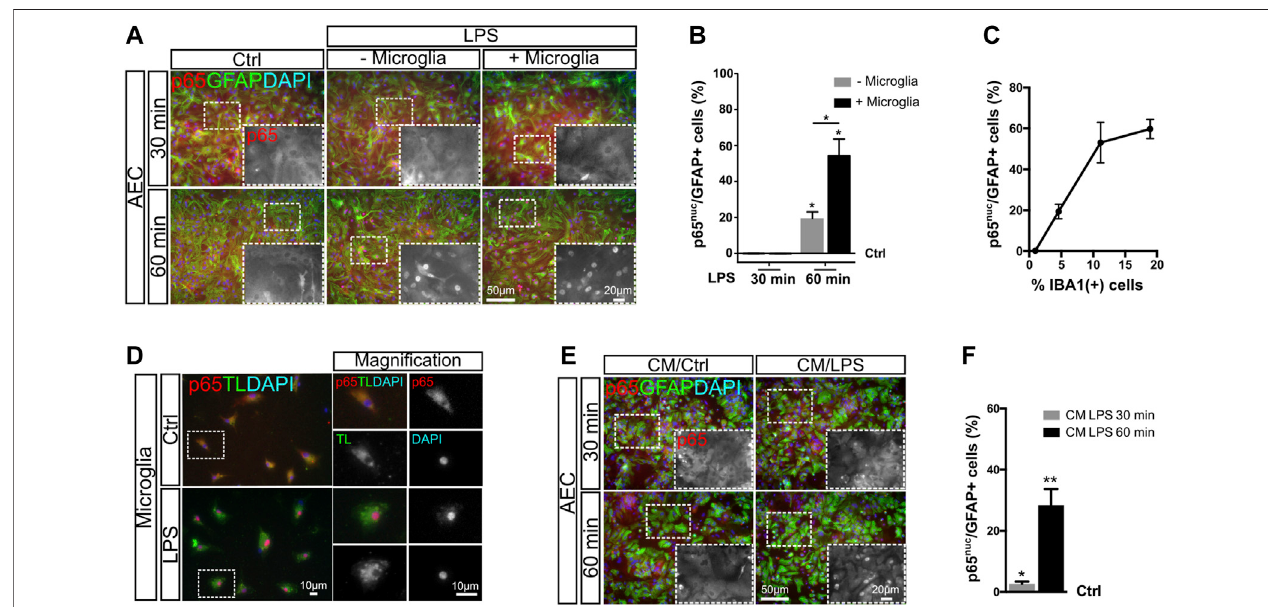
FIGURE 3 | NF- κ B initial activation in astrocytes depends on microglial soluble factors. (A) Astrocyte-enriched cultures (AECs) or microglia-reconstituted AEC (+microglia) were incubated with LPS during the indicated time points in reduced-serum medium. To analyze NF- κ B activation in astrocytes in response to LPS, we performed double immuno fl uorescence staining for GFAP and p65, determining the nuclear p65 localization (p65 nuc ). (B) Graph showing the percentage of GFAP + / p65 nuc -positivecellsfromthetotalGFAP-positivecellsaftersubtractingthepercentage ofGFAP + /p65 nuc fromthecontrol(Ctrl (cid:2) 0).Eachtimepointwascompared to the respective control (no LPS) using one-sample t -test with the statistical signi fi cance represented as * p < 0.05; n (cid:2) 3. Comparisons between treatments were conducted using Student ’ s t-test with the statistical signi fi cance represented as * p < 0.05; n (cid:2) 3. (C) Graph showing the proportion of GFAP + /p65 nuc -positive cells plottedagainsttheabundanceofIba-1 + cellsfromdifferentexperiments.Eachdotcorrespondstoadifferentexperimentandrepresentsthemeanof3differentcultures. (D) Isolated microglia was incubated for 1 h with LPS in reduced-serum medium to obtain microglia-conditioned medium. To analyze NF- κ B activation in isolated microglia in response to LPS, we performed double staining for FITC – tomato lectin and p65, determining the nuclear p65 localization (p65 nuc ). (E) Astrocyte-enriched cultures (AECs) with 1 h LPS-stimulated microglia-conditioned medium during the indicated time points. To analyze NF- κ B activation in astrocytes in response to LPS, we performed double immuno fl uorescence staining for GFAP and p65, determining the nuclear p65 localization (p65 nuc ). (F) Graph showing the percentage of GFAP +